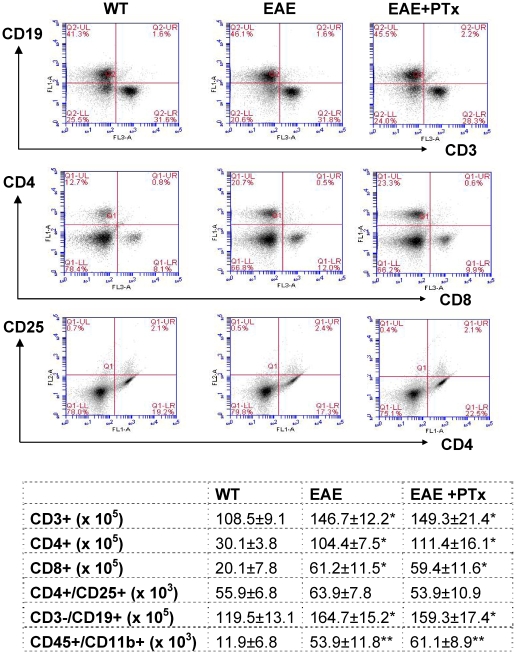
Flow cytometry analysis of mononuclear cells from the spleen on day 14.PTx icv does not alter the peripheral lymphocyte subpopulation in acute EAE. Dot plots of flow cytometry results generated after gating on lymphocytes (by forward and versus side scatter) are shown for T (CD3+, CD4+, CD8+, CD4+/CD25+ and B (CD3−/CD19+) cells. WT = wild type group. Absolute numbers of lymphocyte subpopulation, macrophage/microglia cells are shown in the following table. n = 6/group. * p<0.05 compared with WT, * * p<0.01 compared with WT.